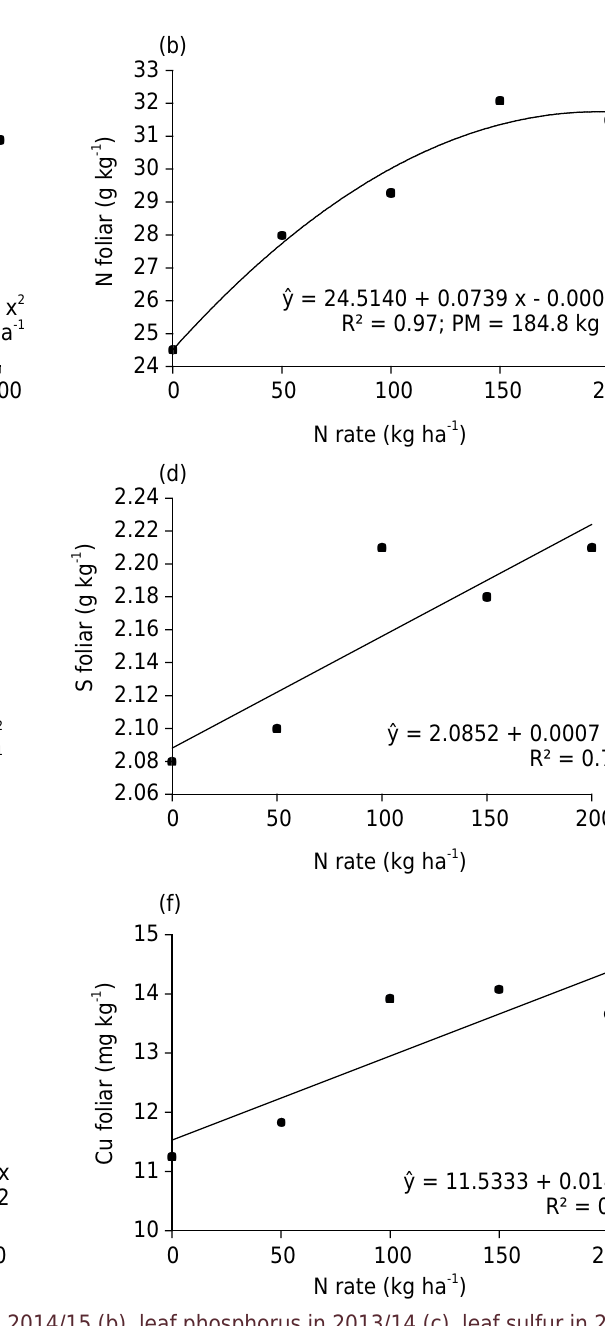
Figure 2. Concentrations of leaf nitrogen in 2013/14 (a) and 2014/15 (b), leaf phosphorus in 2013/14 (c), leaf sulfur in 2013/14 (d) and 2014/15 (e), and leaf cooper in 2013/14 (f) of corn affected by nitrogen